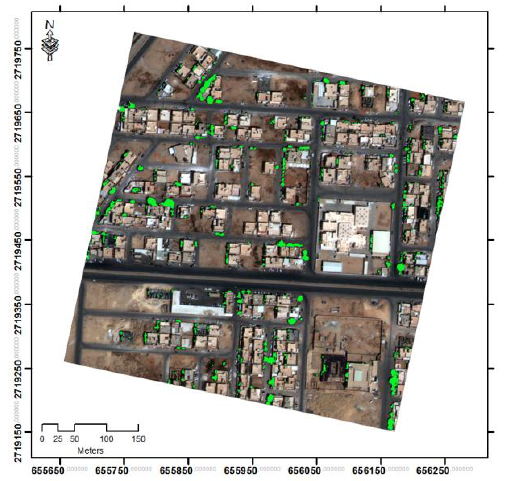
Figure 6. Areas of change potentially containing new buildings (red), superimposed to one GeoEye image. ambiguous matchings. Figure 9 shows some results. Green lines acceptable matching performance.